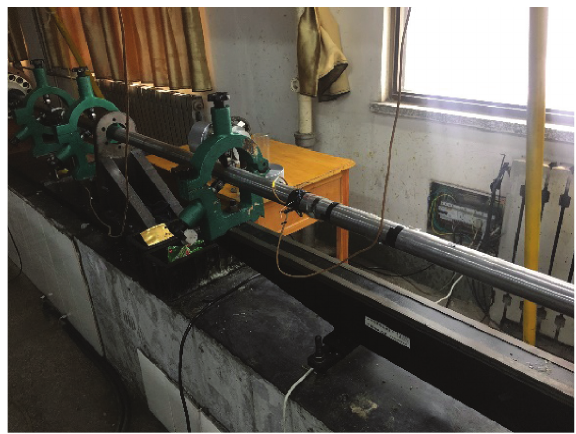
Figure 2: Schematic diagram of the Hopkinson rod test device. Table 6: Static mechanical properties of different